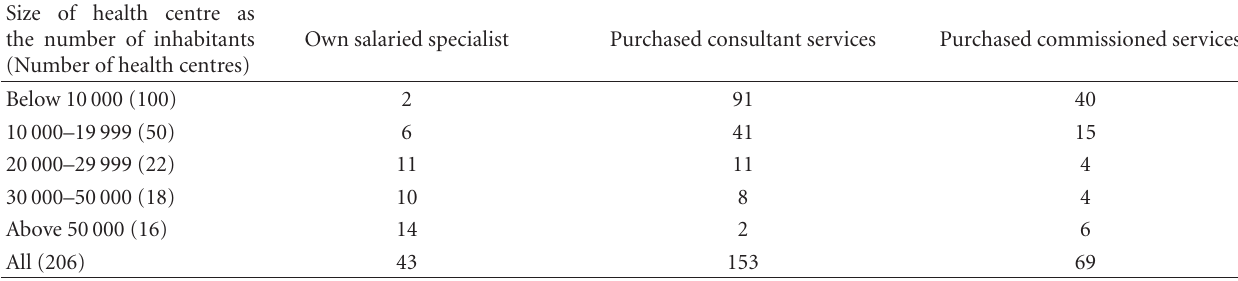
Size of health centre as